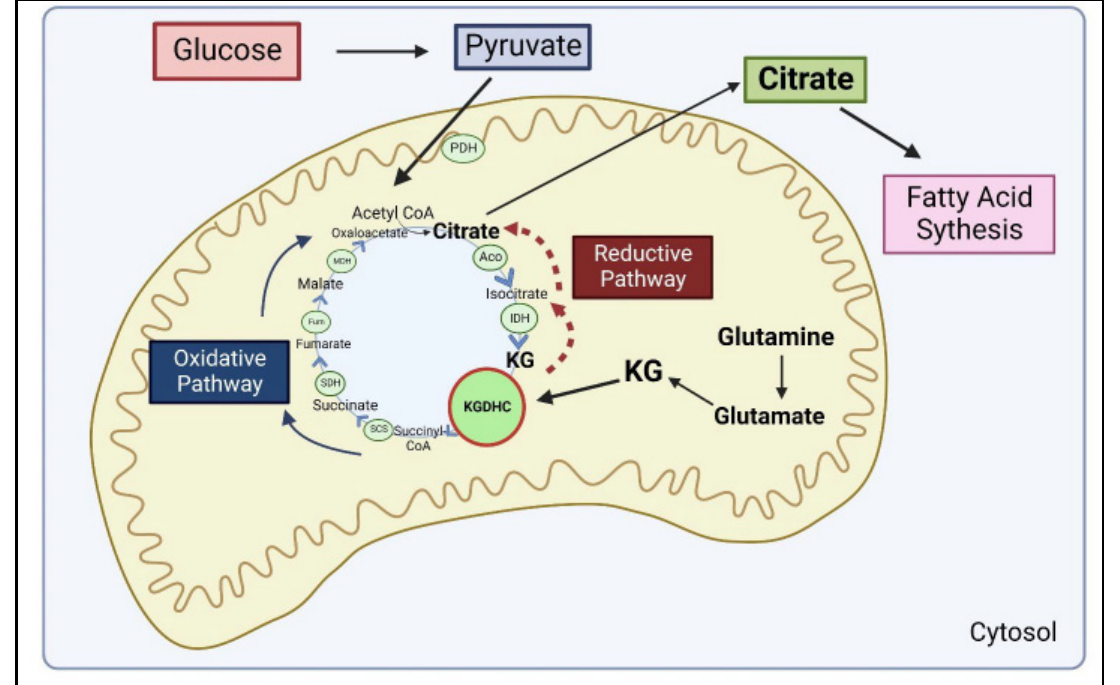
Figure 5. Metabolic plasticity of the α -ketoglutarate dehydrogenase complex (KGDHC). Glucose entering cells is converted to pyruvate which enters the inner mitochondrial matrix. The pyruvate dehydrogenase complex (PDH) oxidizes the pyruvate to acetyl CoA. The tricarboxylic acid (TCA) cycle begins when oxaloacetate combines with acetyl CoA to form citrate which is converted to isocitrate (by aconitase) and then to α -ketoglutarate (KG) by isocitrate dehydrogenase (IDH). KGDHC oxidizes KG to produce succinyl CoA which is converted to succinate by succinyl CoA synthetase. Succinate is converted to fumarate (by succinate dehydrogenase, SDH) then to malate (by fumarase, fum) and finally to oxaloacetate (by malate dehydrogenase, MDH). KGDHC is rate limiting so if it is inhibited, the oxidative pathway is impaired. The inhibition of KGDHC creates a blockage in the TCA cycle, forcing the reductive pathway to occur, which leads to higher amounts of citrate. This citrate is exported out of the mitochondria into the cytosol where it is used for fatty acid synthesis which is necessary for cell proliferation and growth. KG is also produced from glutaminolysis which can enter either the reductive or oxidative pathways of the TCA cycle depending on the activation of